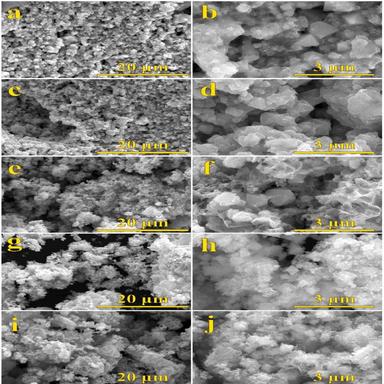
SEM images of the as-synthesized TMOs contrasting different fractions of Ni, Co, and Ru. Electrode: (a-b) TMO-1; (c-d) TMO-2; (e-f) TMO-3; (g-h) TMO-4, and (i-j) TMO-5.